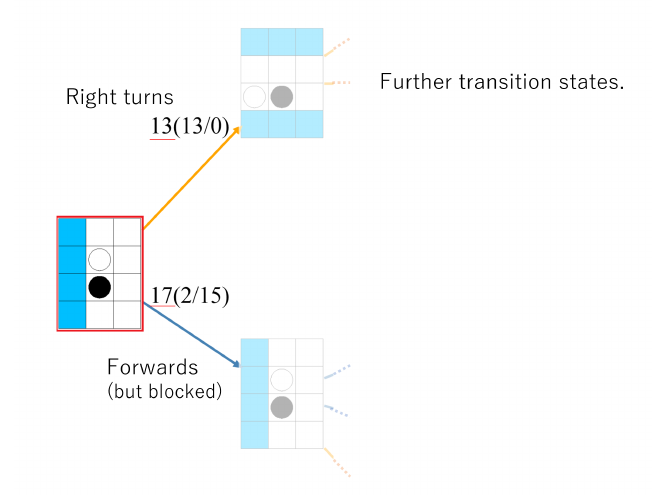
Figure 6. Example of score calculation.